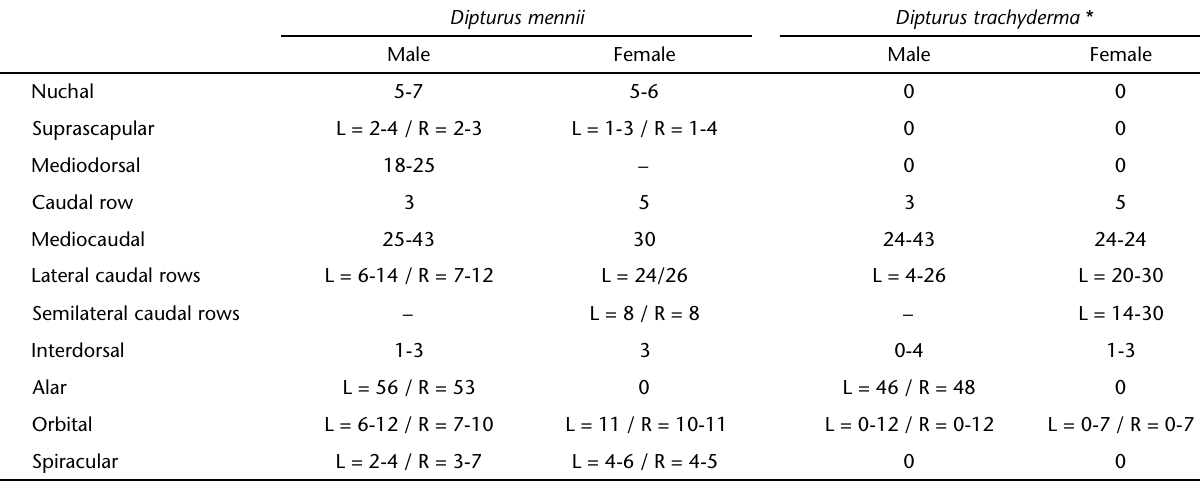
Table III. Comparison of thorn counts in specimens of D. mennii and D. trachyderma . (R) Right, (L)